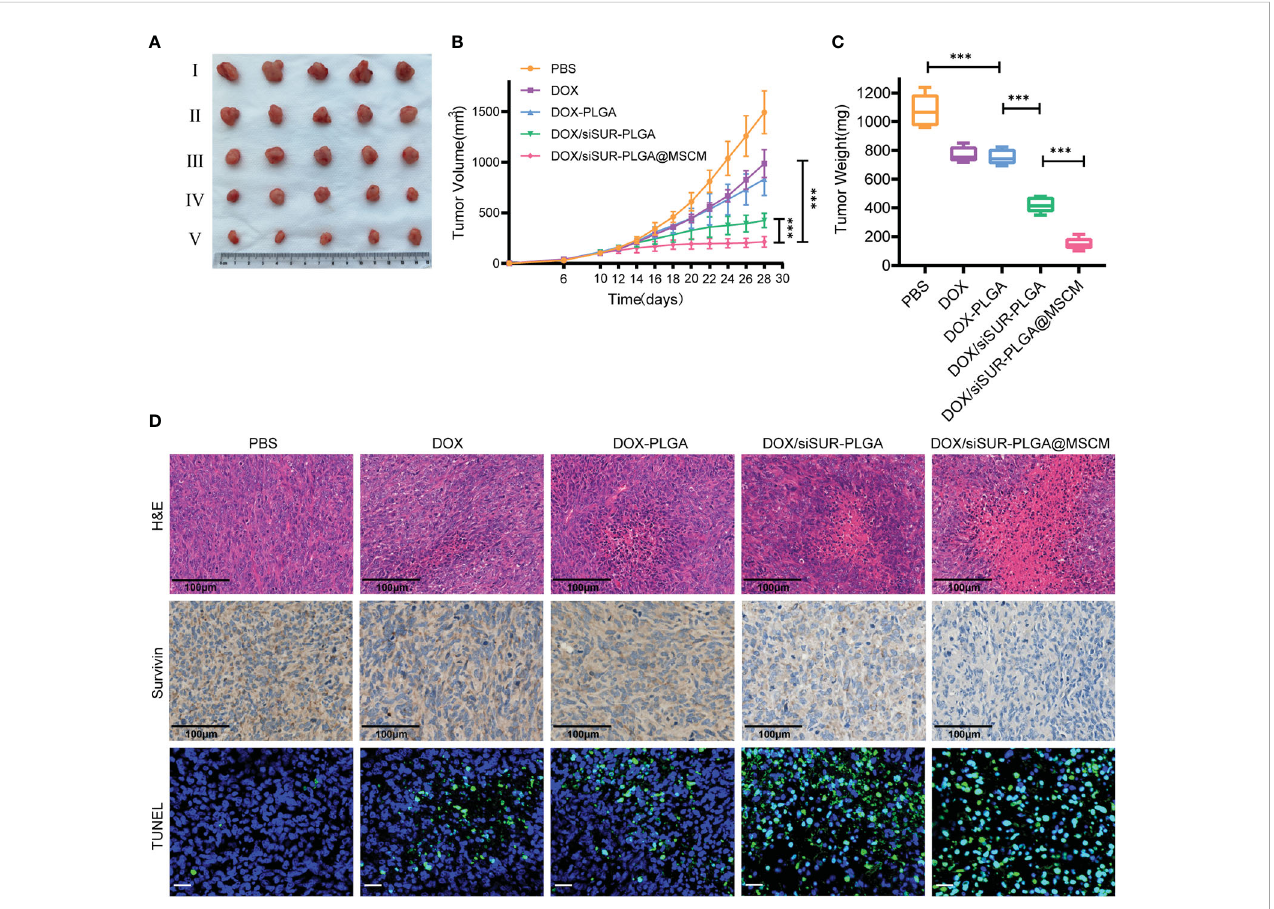
FIGURE 6 In vivo treatment of tumors. (A) Subcutaneous tumor-bearing MG63 mice were treated at a fi xed DOX dose (5 mg/kg) every 2 days by intravenous injection. Start treatment on day 10, end treatment on day 24, and after 8 treatments observation for 4 days, photographs of tumor tissues were captured on day 28 (I PBS, II DOX, III DOX-PLGA, IV DOX/siSUR-PLGA NPs, V DOX/siSUR-PLGA@MSCM NPs). Tumor growth during treatment (B) and tumor weight after treatment (C) were recorded. (D) H&E staining of tumor tissue (scale bar, 100 m m), immunohistochemical analysis of survivin expression (scale bar, 100 m m), and TUNEL assay data (scale bar, 25 m m). ***p <0.001,